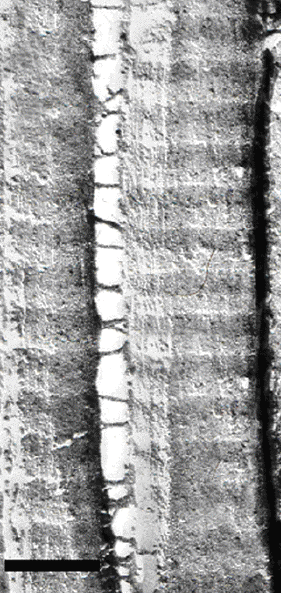
FIGURE 6. Orthogonally-oriented PGs interconnecting two collagen fibrils are clearly revealed by the freeze-etching process. Bar = 0.2 μ